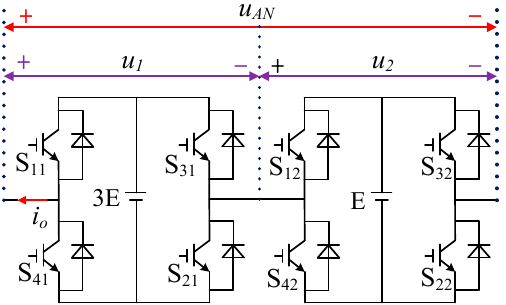
Figure 1. Topology of Type-III Asymmetric Cascaded H-bridge (ACHB) Inverter.